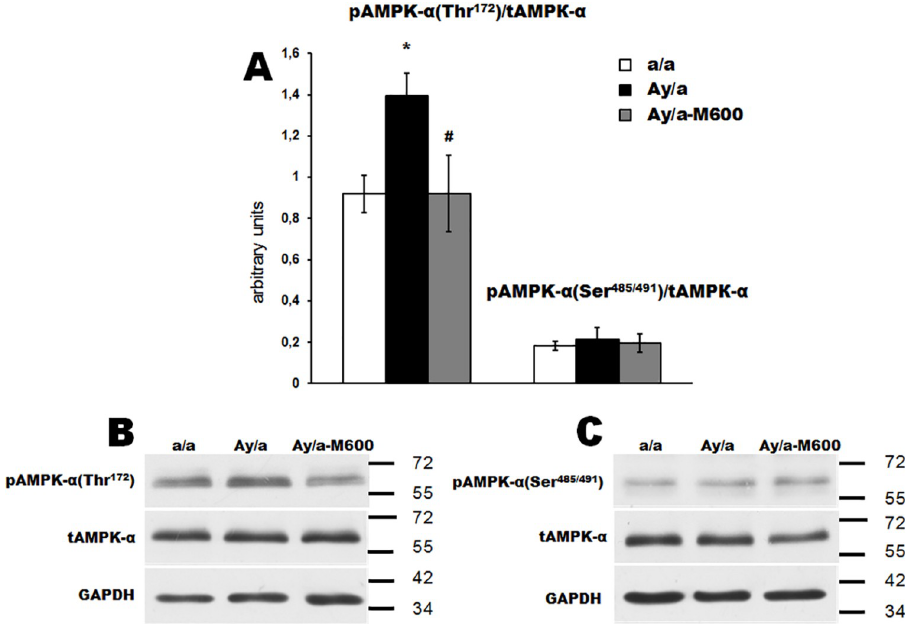
Fig 4. Phosphorylation of AMPK α -subunits in the hypothalamus of obese agouti-mice and the effect of metformin treatment. (A) The histograms for the ratio of the Thr 172 - and Ser 485/491 -phosphorylated α 1/2-AMPK and the non-phoshorylated α 2-AMPK. (B) and (C) The Western blotting for the Thr 172 - and Ser 485/491 -phosphorylated forms of α 1/2-AMPK, respectively. The data are presented as the M ± SEM . � —the difference between the Groups a/a and Ay/a is significant at the P < 0.05, #—the difference between the Groups Ay/a and Ay/a-M600 is significant at the P < 0.05. In each group: n =